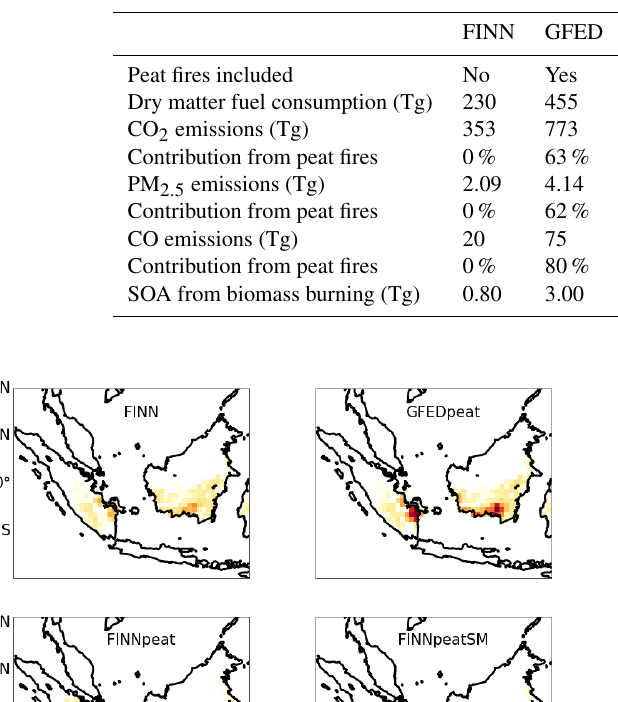
Table 4. Total dry matter fuel consumption, PM 2 . 5 , CO 2 , CO and SOA fire emissions for September–October 2015. Totals are for the area shown in Fig. 1. The percentage contribution from peat fires is indicated.